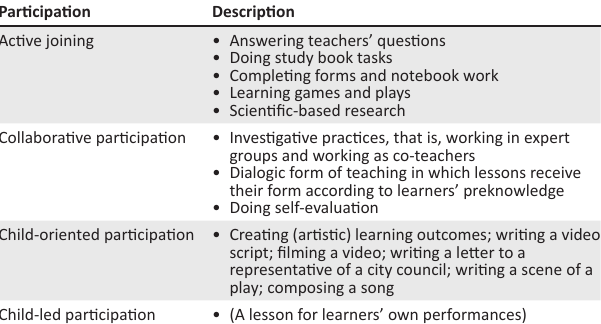
TABLE 2: Results presented in the model of documentation form. Participation Description Active